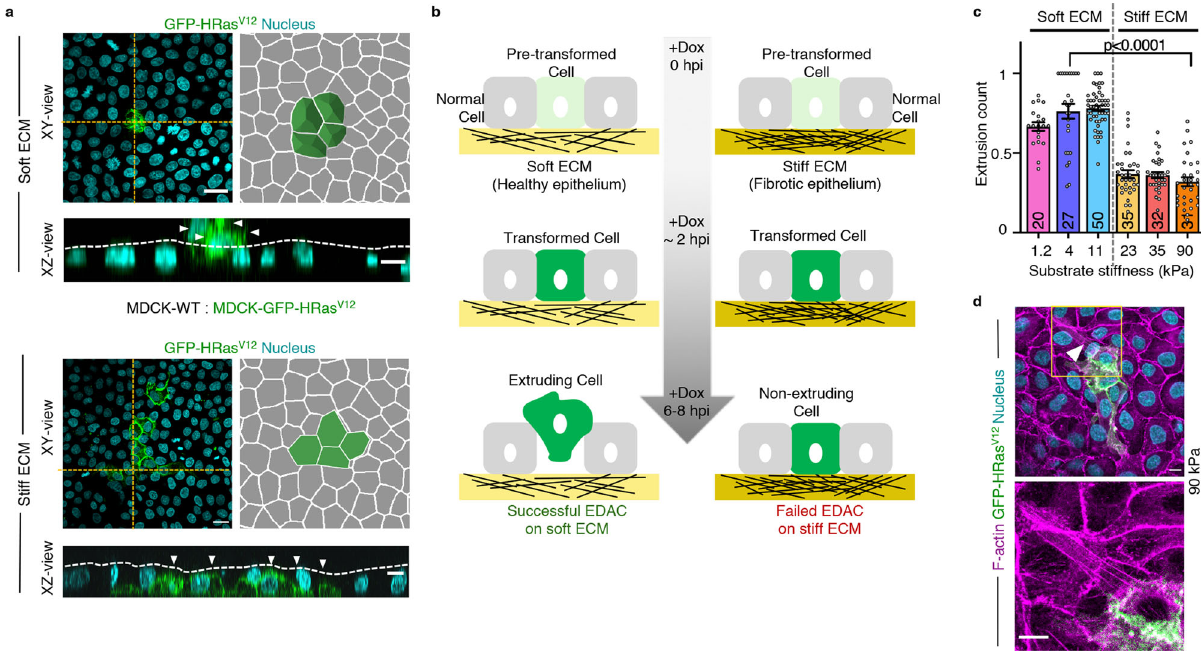
Fig. 1 Matrix stiffening attenuates extrusion of HRas V12 -transformed cells during EDAC. a Fluorescence images of GFP-HRas V12 expressing colony extrusion on soft (4 kPa) and stiff (90 kPa) substrates in XY -plane; followed by an illustration depicting the visual metric employed to quantify extrusion. Rounded-up cells expressing GFP-HRas V12 (as seen on soft ECM) are taken as extruded. Non-extruded GFP-HRas V12 cells remain in-plane with other cells, as evident on stiff ECM. ( Bottom panels ) The yellow-dotted lines visually guide the epithelium surface in XZ -plane. GFP-HRas V12 cells extruded over this surface on soft ECM ( top ) whereas they remained within this surface on stiff ECM ( bottom ). White arrowheads indicate GFP-HRas V12 cells. b Diagram representing different phases of extrusion of transformed cells and stiffness-dependent outcome of EDAC. c Scatter bar plot depicting the fraction of GFP- HRas V12 expressing colonies extruded over substrates of varying stiffness at 6 hpi. Distinct decrease in extrusion of transformed cells observed with increase in substrate stiffness. The number of colonies counted is indicated inside each bar. Data are mean ± s.e.m. collected over three independent biological replicates. Statistical signi fi cance was assessed using Mann – Whitney t -test (two-tailed). p = 2.8490e − 08. d Cytoskeletal morphology of non- extruded colonies over stiff ECM at 24 hpi. White arrowheads indicate basal actin fi bres associated with HRas V12 - cells on stiff ECM (90 kPa), stained with AlexaFluor647-Phalloidin. Inset: Magni fi ed view of the yellow-boxed region with actin fi bres pointed out by white arrowheads. Scale bars = 20 μ m ( a , XY- view), 10 μ m ( a , XZ-view; d